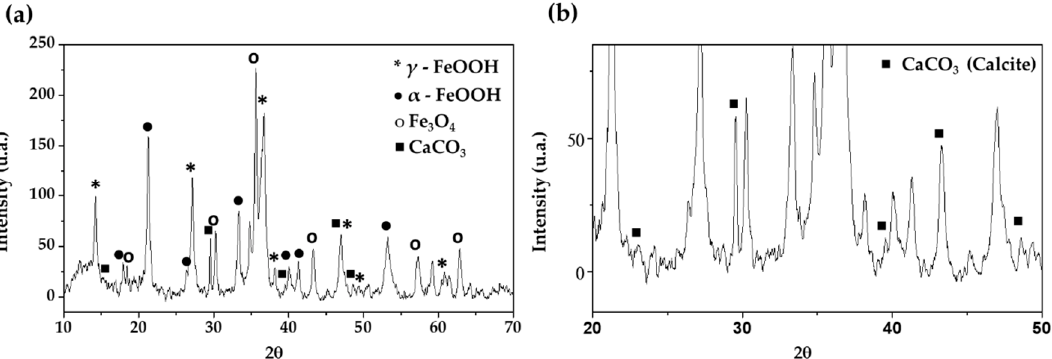
Figure 3. XRD spectra of corrosion products formed on B450C carbon steel surface ( a ) and CaCO 3 spectra ( b ) after 30 days of exposure to chloride-containing cement extract solution.